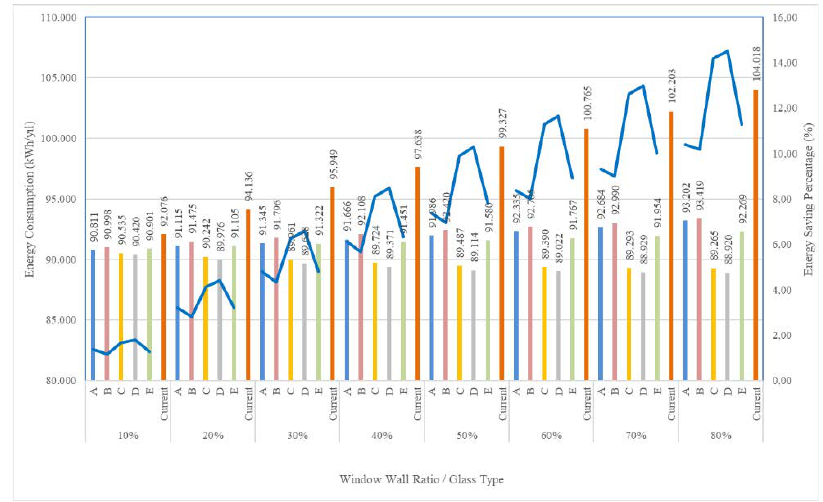
Figure 7 Energy saving rates, calculated energy consumptions and reference energy consumptions for